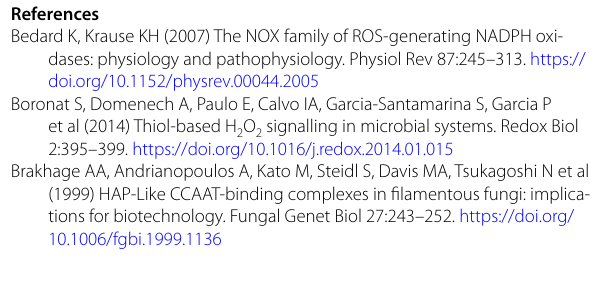
Fig. S7. Replacement of gsdA native promoter with gpdA promoter also perturbed NADPH rhythm and impaired fungal resistance to H 2 O 2 . A –